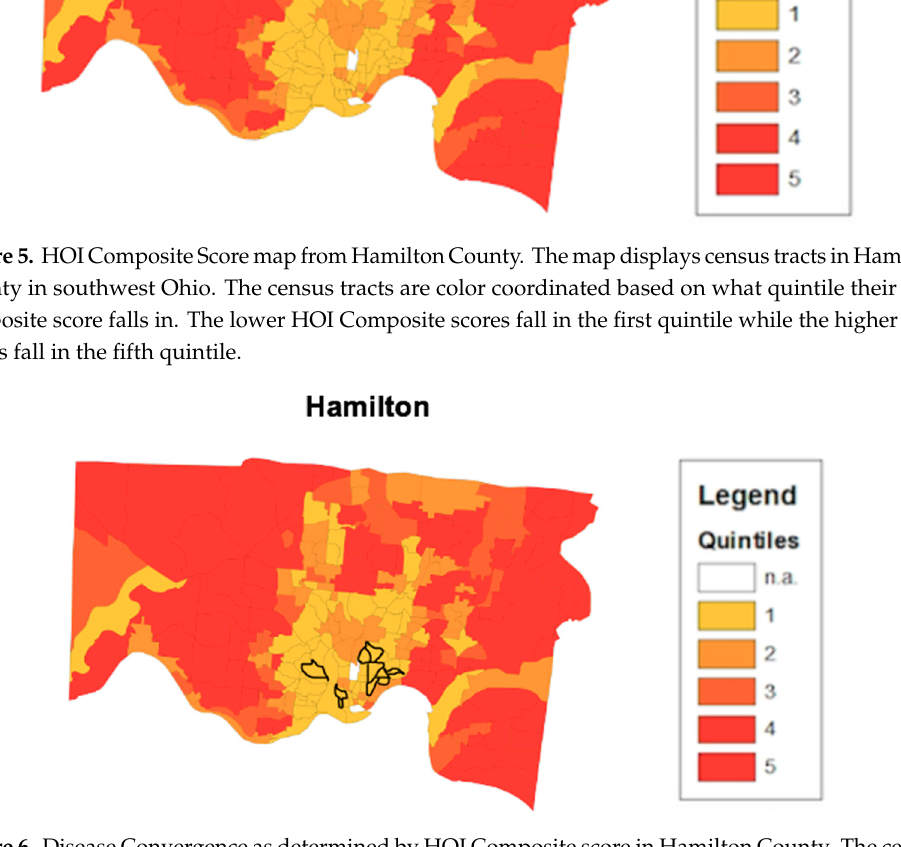
Figure 6. Disease Convergence as determined by HOI Composite score in Hamilton County. The census tracts outlined in black indicate the disease convergent census tracts. The indicated census tracts are areas where multiple diseases are occurring at high levels, simultaneously.